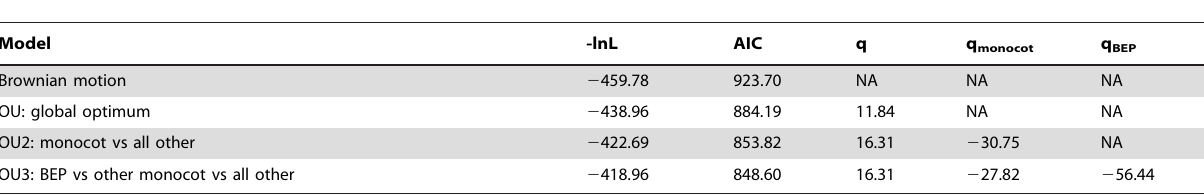
Table 1. Evolutionary models of leaf wax hydrogen isotopic discrimination.